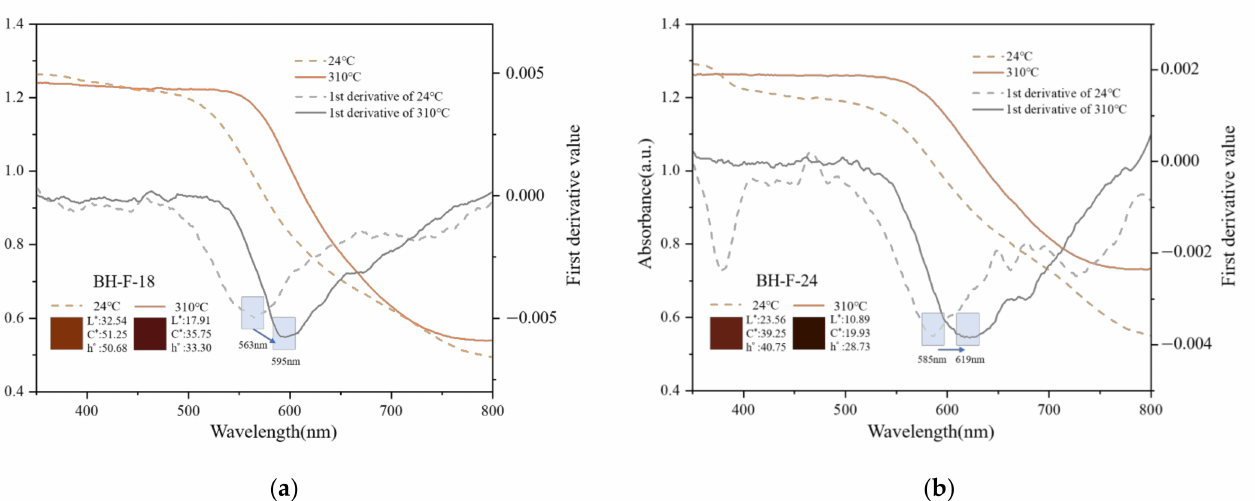
Figure 10. Comparison of 24 Beihong agate samples before and after heat treatment at 310 ◦ C. The colour square shows the simulated colour of Beihong agates. Left: Before heat treatment. Right: After heat treatment. The white value below represents the colour difference before and after heat treatment. It shows that most samples change from yellow to red after heat treatment. According to the values of colour difference, orange samples changed more in colour after heat treatment, presuming that the relative contents of goethite in these agates can be higher.